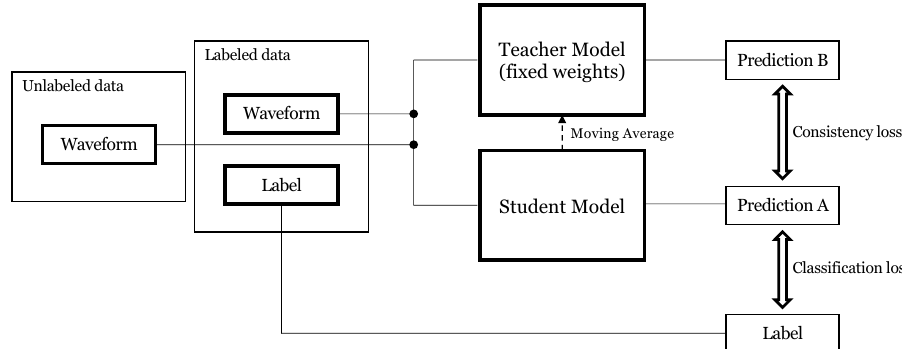
Figure 3. Schematic diagram of the mean-teacher model for semi-supervised